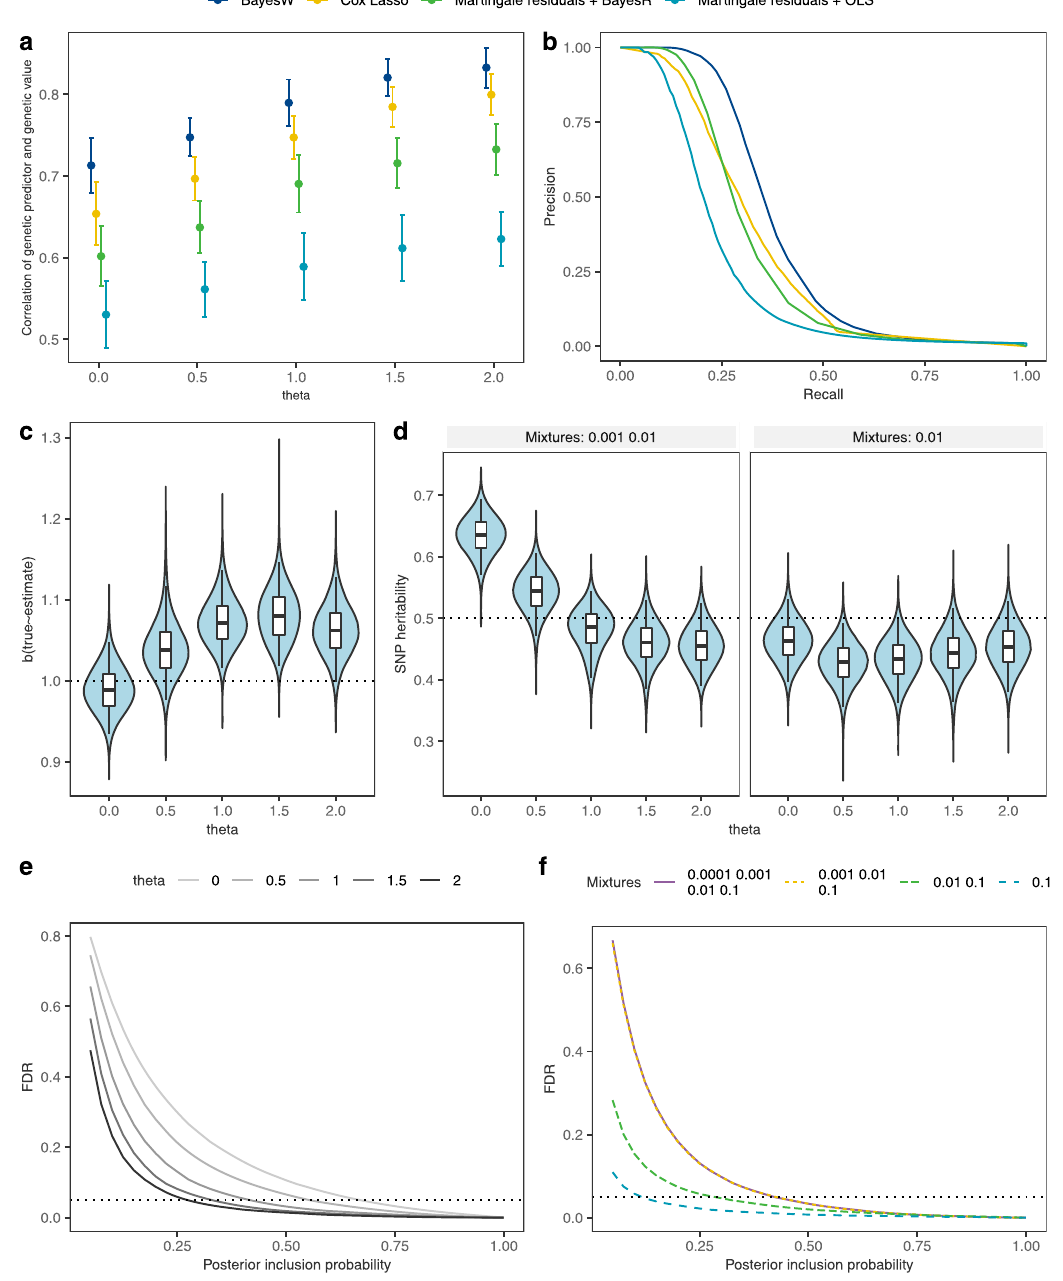
Fig. 1 Simulation study results. Method comparison, parameter estimation results and the behaviour of the false discovery rate (FDR). Models were estimated on a data set of M = 50,000 uncorrelated markers and N = 5000 individuals in 25 replicate simulations of 5 chains with 3000 iterations. Phenotypes were created from Generalised gamma distributions (see Supplementary note) using p = 500 causals markers and retaining heritability of h 2 = 0.5; independent data set had the same markers with N = 1000 other individuals. a Prediction accuracy of four methods when predicting to an independent data set given different generalised gamma distributions. The plot centres indicate the mean and error bars indicate the standard deviation of the correlations across simulations; ( b ) Mean precision values for each level of recall for four methods using Weibull phenotype (theta = 1); ( c ) Regression slope (true effect size ~ estimated effect size) when estimating non-zero marker effects given different theta values estimated with BayesW at each iteration across all simulations; ( d ) BayesW SNP heritability estimates given different generalised gamma distributions and different used mixtures at each iteration across all simulations; ( e ) relationship between the posterior inclusion probability (PIP) and false discovery rate (FDR) given different generalised gamma distributions for BayesW, for each PIP we present mean FDR values; ( f ) relationship between the PIP and FDR for a different number of mixture distributions used using Weibull phenotype and BayesW, for each PIP we present mean FDR values. In panels c – d , the bounds of the box show the interquartile range, centre shows the median and minimum and maximum indicate the 95% credibility